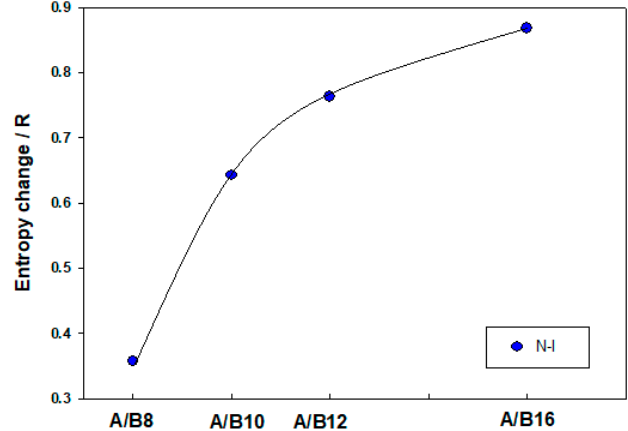
Figure 5. Entropy changes as a function of chain length (n) of present HBSMCs A/2Bn.